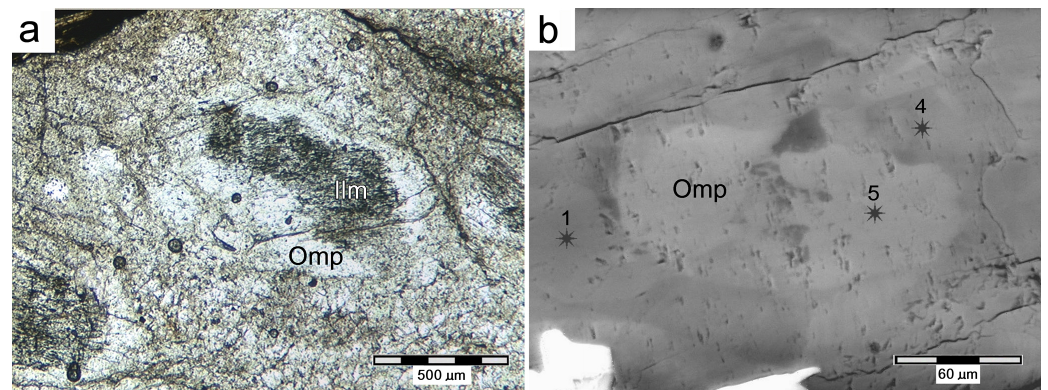
Figure 11. Photomicrographs of garnet omphacitite: (a) porphyroclast of an omphacitic pyroxene (Omp), which shows a dusky core with tiny inclusions of ilmenite (Ilm) (3975, PPL). (b) An unusual zoning for pyroxenes, in which an older omphacitic core (light grey; Omp) is surrounded by a darker rim, richer in Na and Al (7736, SEM image, BSE); the numbered stars indicate the spots in which EDS analyses were collected (see Table